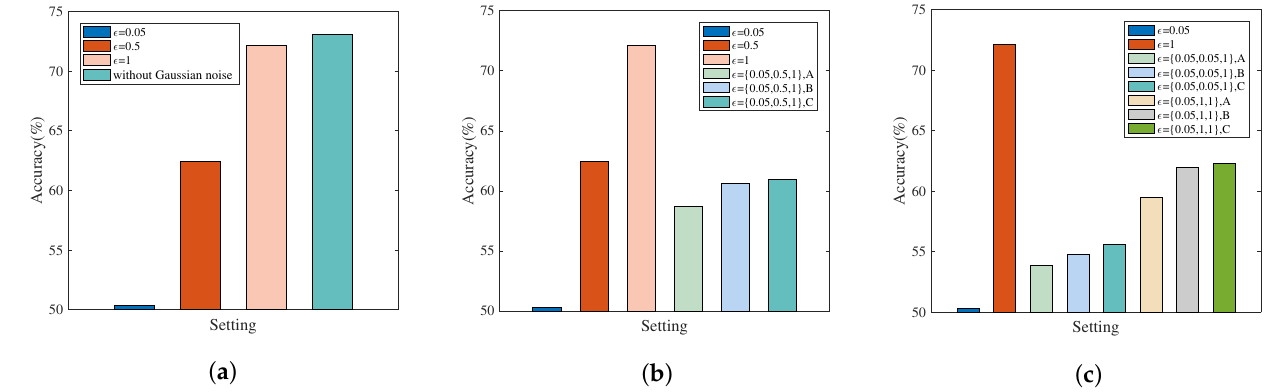
Figure 3. Simulation results on Fashion-MNIST data. Clients’ training data are independent and identically distributed. ( a ) The non-personalized scenario. ( b ) The personalized scenario under the first privacy setting. ( c ) The personalized scenario under the second privacy